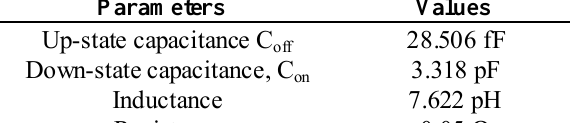
Figure 8: (a) Return loss performance with fixed width/variable length notches (b) Insertion loss variation with fixed width/variable length notches